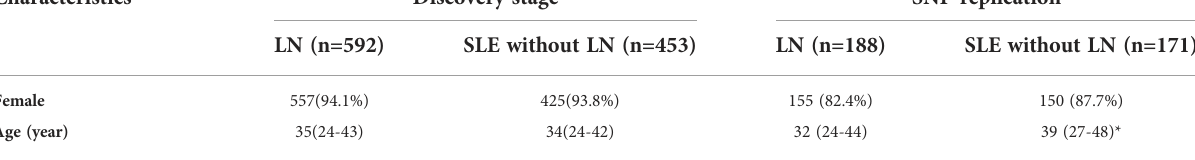
TABLE 1 Characteristics of patients in the